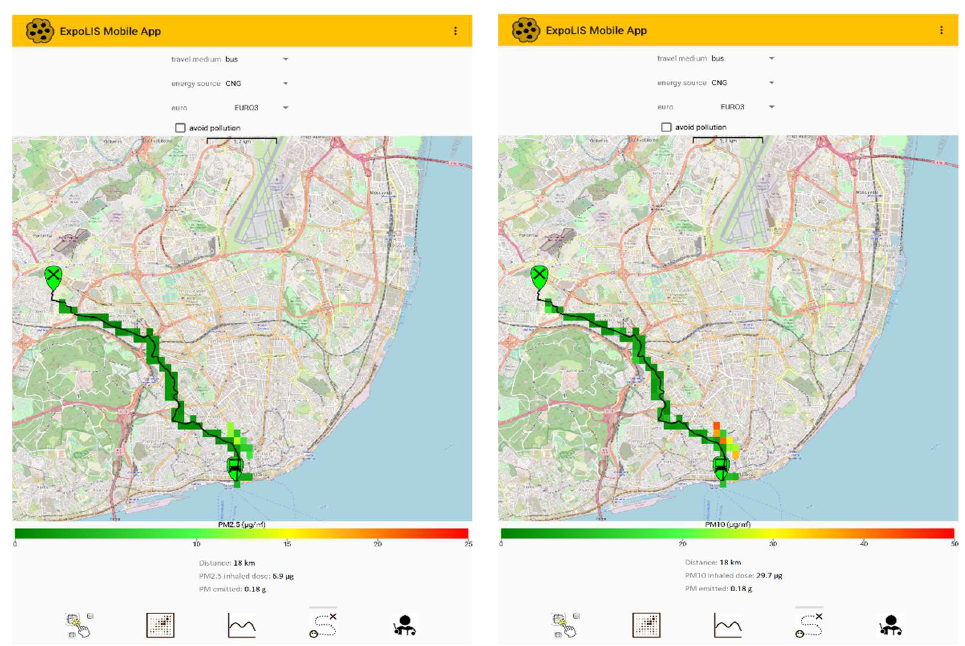
Figure 7. Screenshots of the ExpoLIS Health Optimal Routing Service App for the four selected routes when commuting by a Euro 3 bus powered by Compressed Natural Gas (CNG), with the representation of the spatial distribution of outdoor PM2.5 and PM10 concentrations, and the indication of the respective PM inhaled dose and emission.